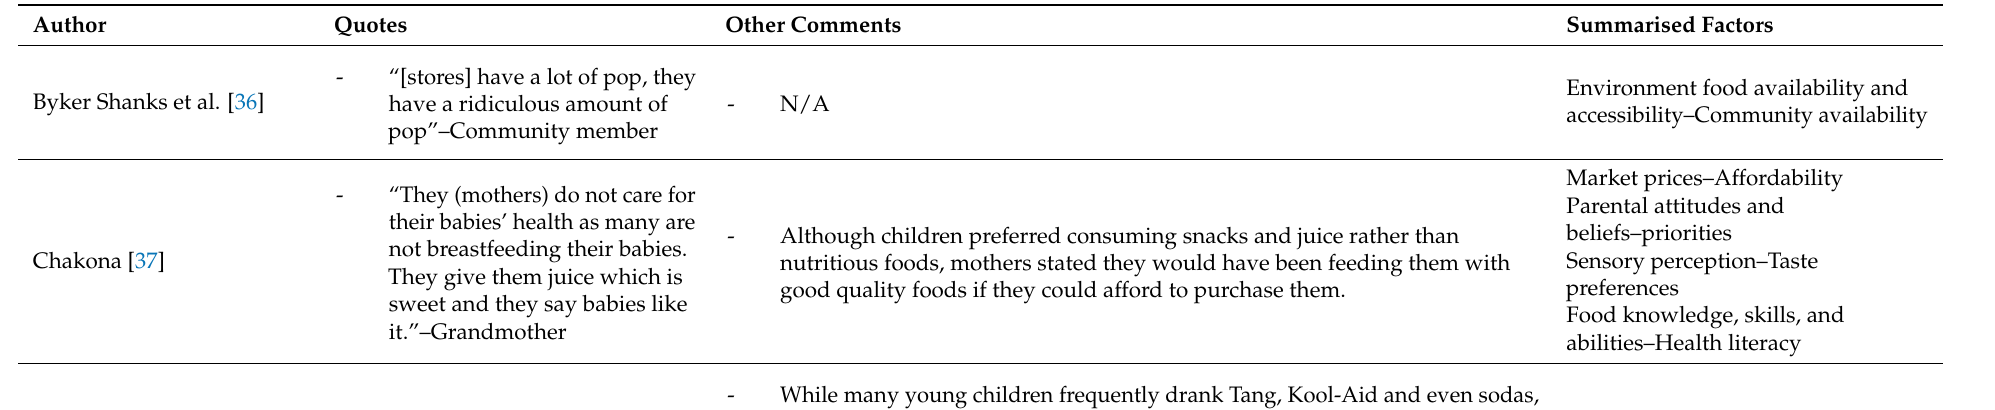
Table 6. Factors influencing SSB consumption extracted from the included mixed-methods